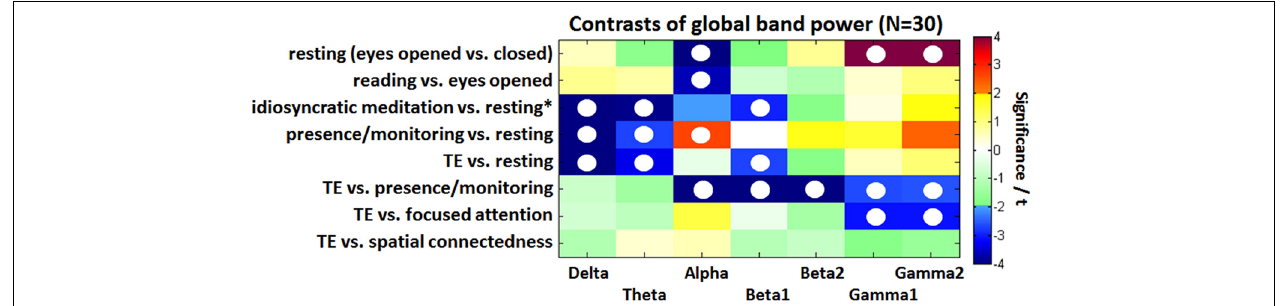
FIGURE 3 | Color-coded PSD differences shown as t -values resulting from the eight standard comparisons between psychophysiological states during the recording sessions for seven distinct frequency bands, averaged over 30 experienced meditators. The colors are coding t -values.